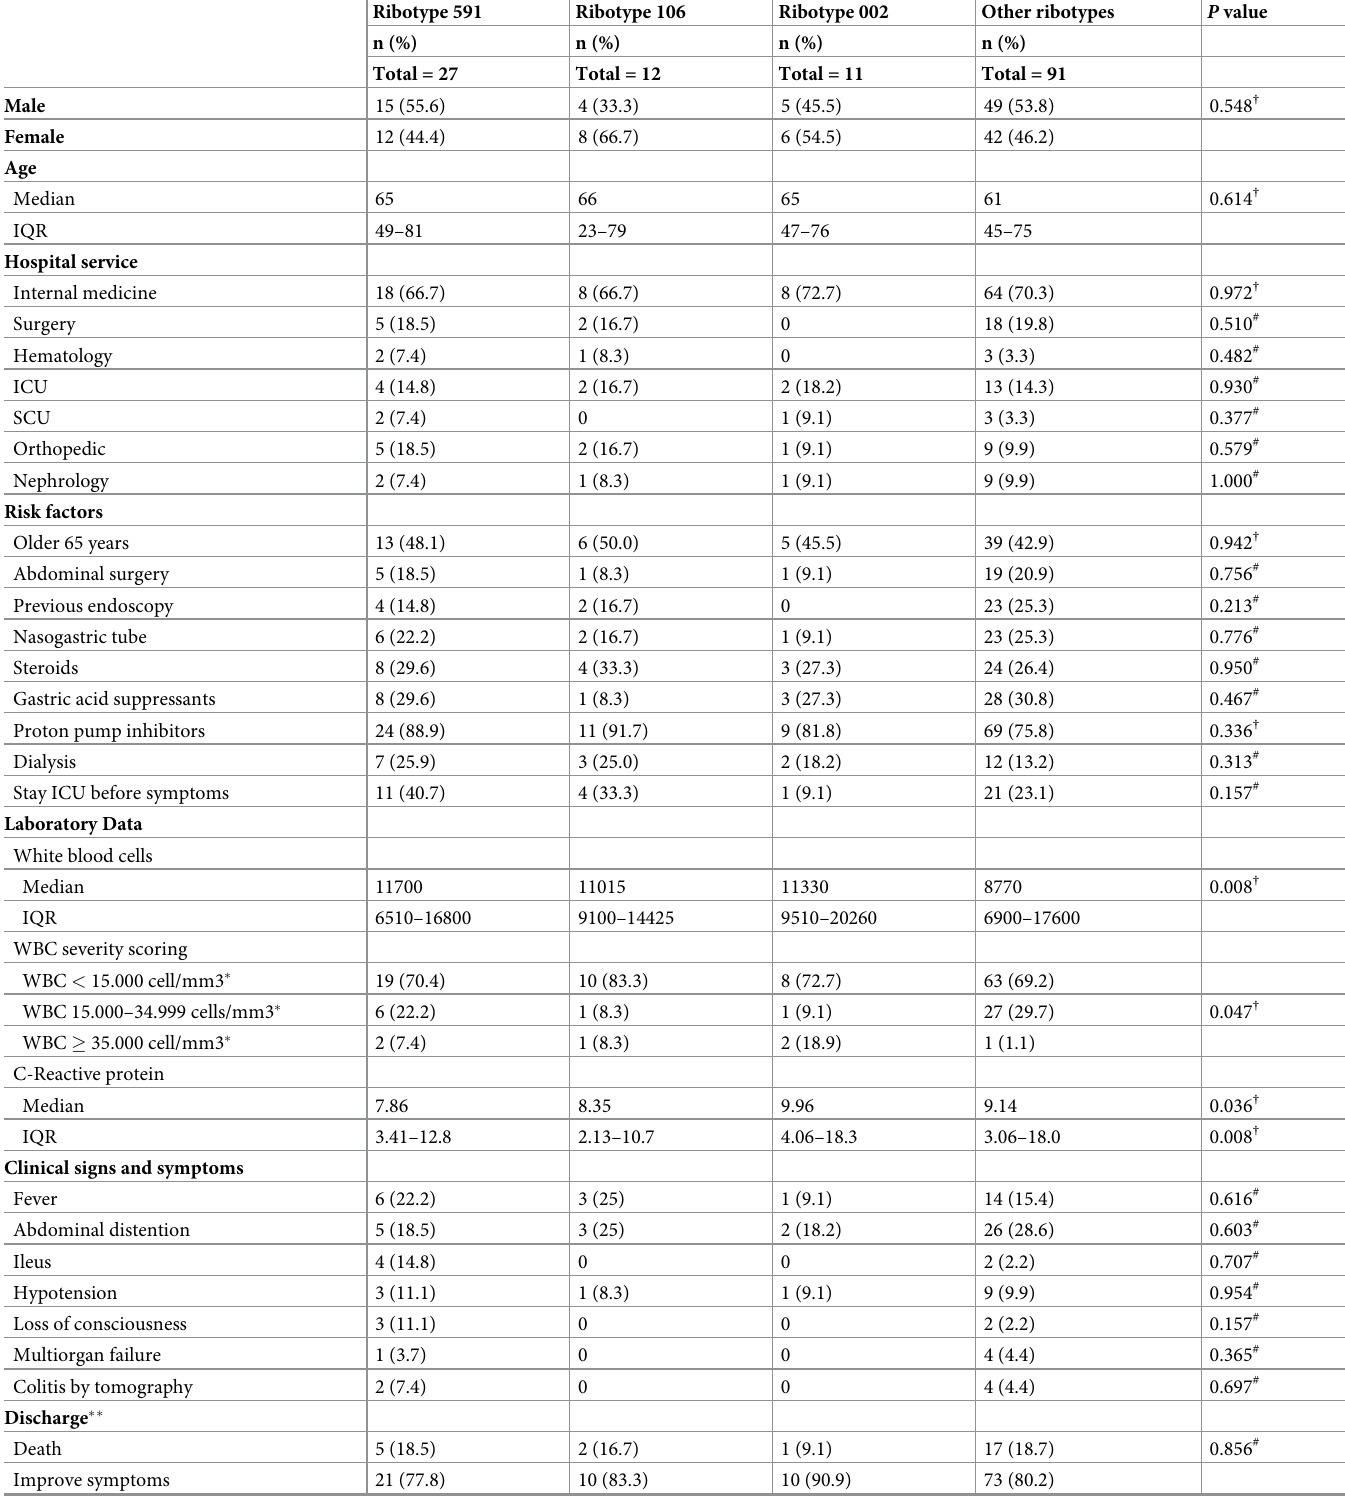
Table 1. Demographic and clinical characteristics of patients carrying the 591, 106, 002 and other